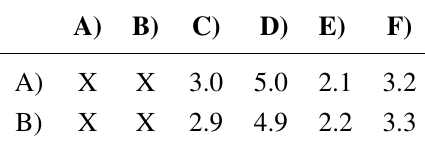
Table 3. Fictitious example: common exposures of institutions A and B